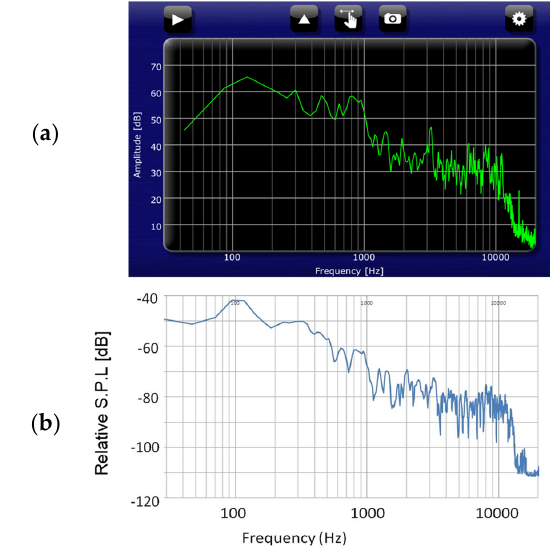
Figure 2. Example of results of accuracy test of FFT frequency spectrum analysis application (bs-spectrum) for iOS devices measured by ( a ) iPod Touch 4 and ( b ) professional-use PC software [12].